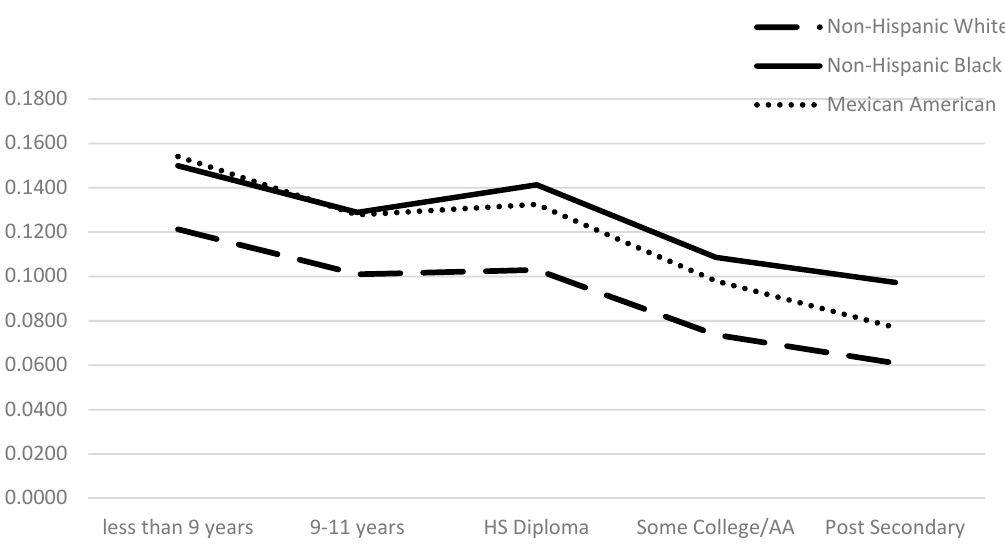
Figure 1. Predicted probability of intermediate c-reactive protein by education and race/ethnicity. Note: Differences across groups statistically significant at the p < 0.001 level. Model controls for age, diabetes, heavy drinker, HBP, HWC, income, sex, smoker, and statin